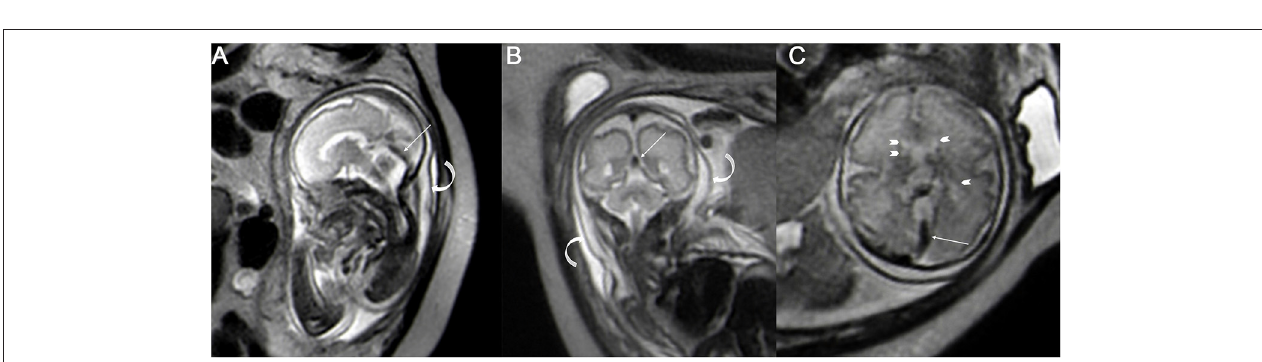
FIGURE 2 | The single shot-fast spin-echo sequence for a fetus with heart failure at a gestational age of 30 weeks; the sagittal plane (A) and coronal plane (B) and axial plane (C) show the dilated straight sinus (straight arrow), and the extensive subcutaneous edema ( A , B curved arrow) and sub-ependymal cysts can be seen around the bilateral lateral ventricles ( C